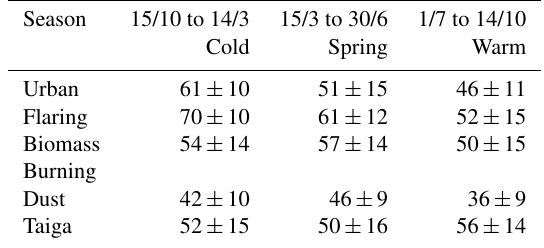
Table 1. Lidar ratio at 808nm in sr for the five FLEXPART-derived aerosol types and three seasons (cold, spring and warm) when using independent AOD